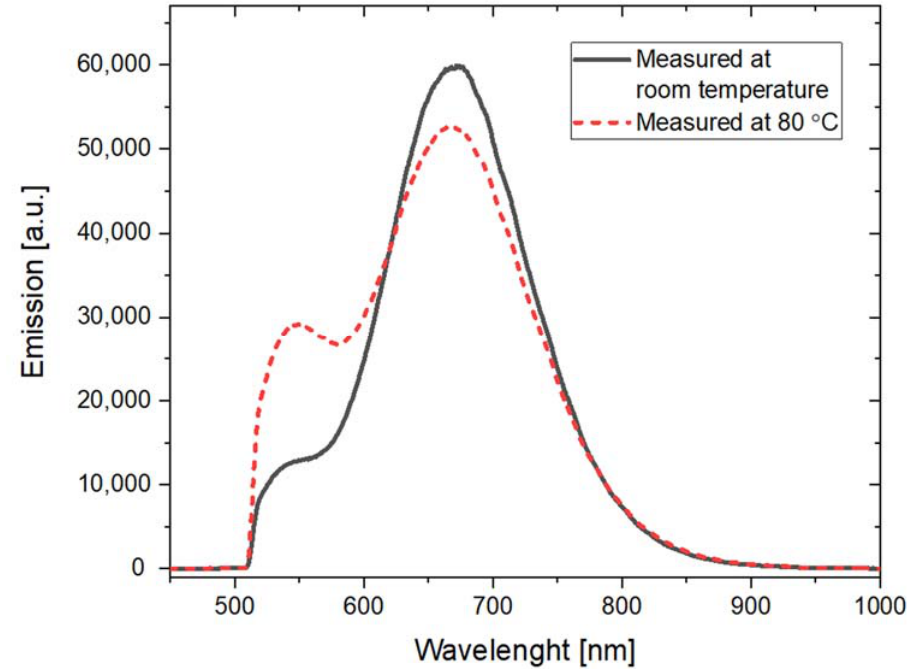
Figure 14. Photoluminescence emission spectra measured at room temperature and 80 °C for the sample irradiated with the alpha particles from Am-241 source (fluence 10 12 cm − 2 ). Excitation at 440 nm.